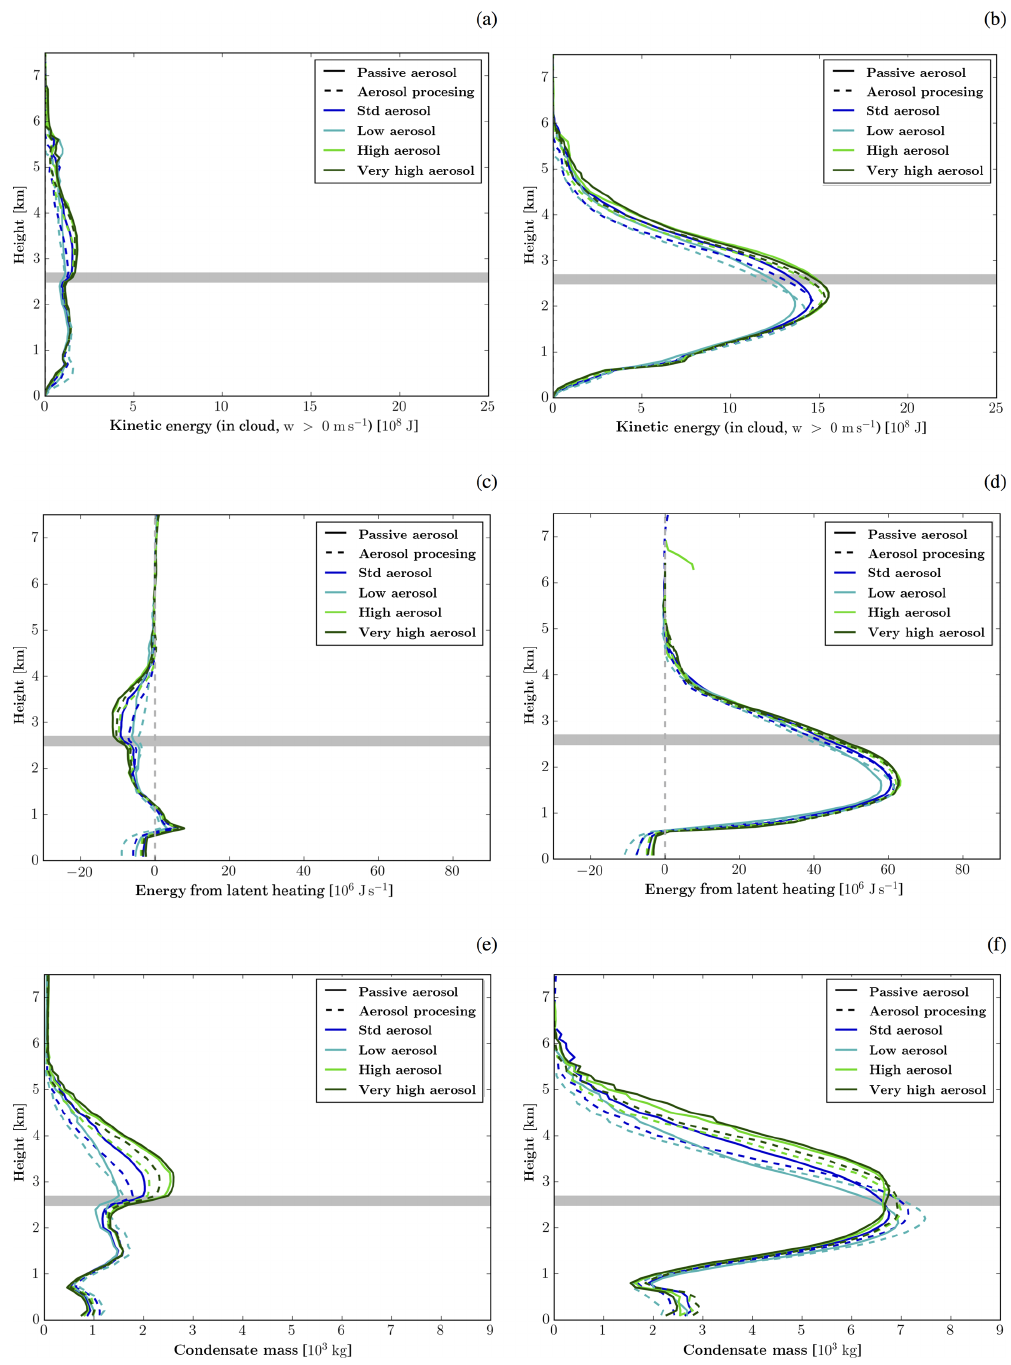
Figure 10. Average profiles of (a, b) kinetic energy from vertical velocity, (c, d) latent heat release, and (e, f) condensate content. The left panels shows the average over all columns with a column maximum in-cloud vertical velocity of w max = 0–3ms − 1 and the right panels for those with w max > 3ms − 1 . The grey horizontal line indicates the location of the 0 ◦ C